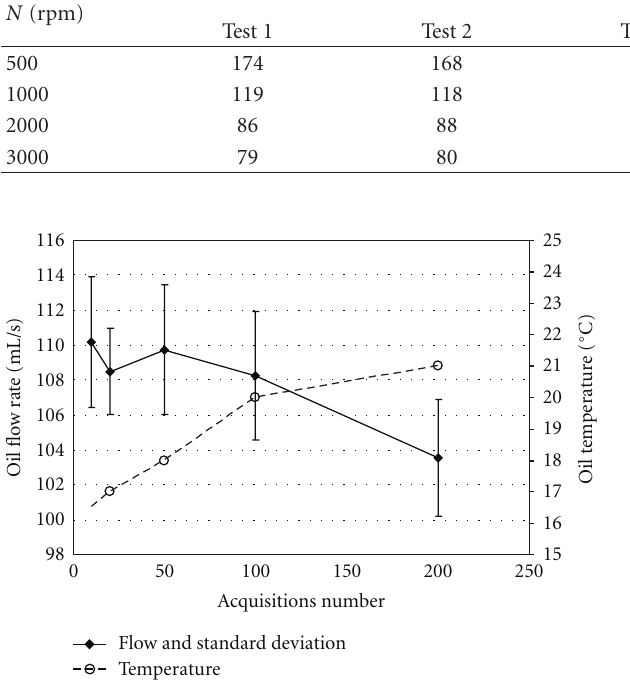
Figure 4: Influence of the number of acquisitions on flow rate measurement.